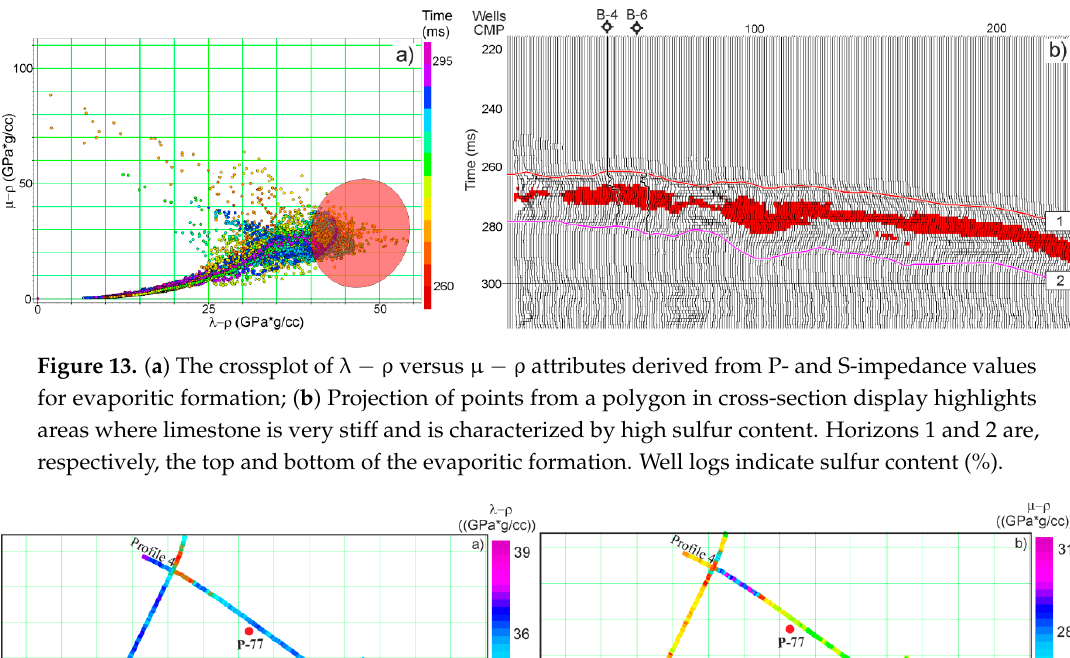
Figure 12. Part of the profile 2 showing zone of interest as: ( a ) λ - ρ , ( b ) μ - ρ . Well logs indicate sulfur